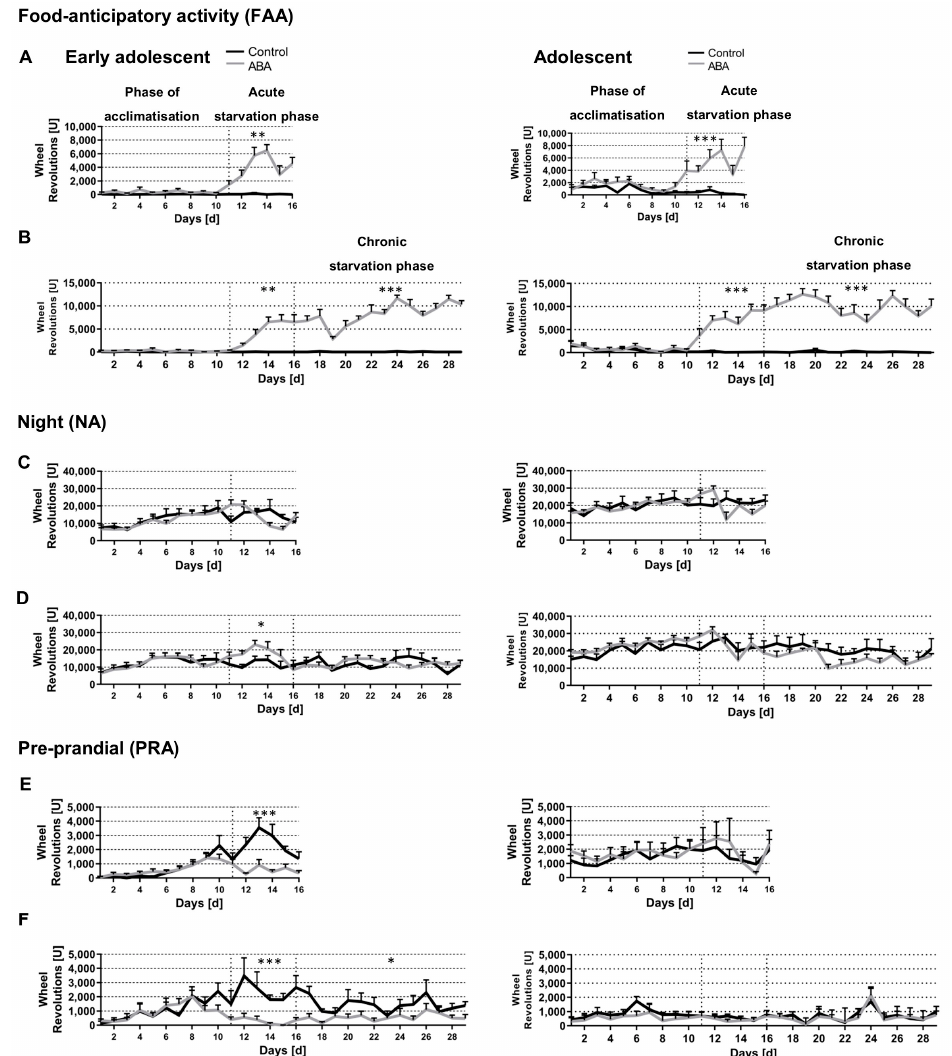
Figure 5. Acute and chronic starvation lead to an increase in food-anticipatory activity. ( A , B ) The food anticipatory activity (FAA, 4 h, from 10 a.m. to 1 p.m.), ( C , D ) the night activity (NA, 12 h, 6 p.m. to 6 a.m. the next day), and ( E , F ) the preprandial activity (PRA, 4 h, 6 a.m. to 10 a.m.) stages during acute and chronic starvation in early adolescent (left) and adolescent mice (right) were investigated using running wheel sensors. * p ≤ 0.05, ** p ≤ 0.01, *** p ≤ 0.001, two-way ANOVA with repeated